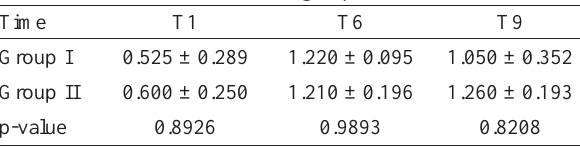
Table 2. SOFA score in the two